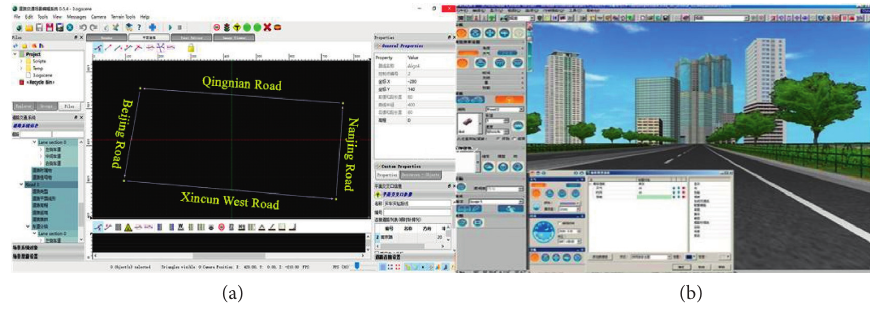
Figure 7: The simulation-based experiment route and street view.